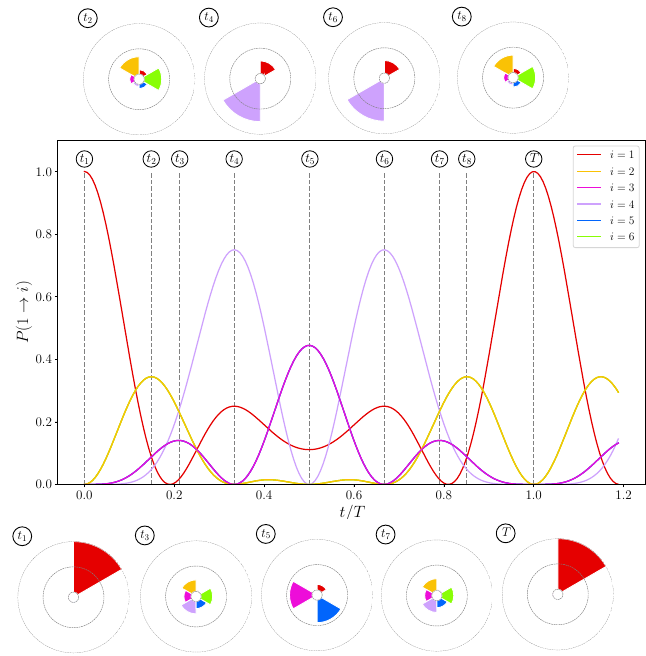
Figure 2. The flow of probability around the ring of fermions for N = 6 sites and q = 10 3 . The neutrino is initialised at t = 0 in the active, i = 1 state and, as time evolves, may overlap with the other N − 1 sites, before returning to a maximum of being detected in the n = 1 state again after a time T . The probability that the system is in the i th site on measurement after a time t is shown in the main figure, in units of the cycle period T . The circular bar charts illustrate, to scale, the flow of probability around the sites, plotted in the same colours as in the main figure, at a number of instances. The inner and outer concentric dashed circles denote measurement probabilities of 0.5 and 1